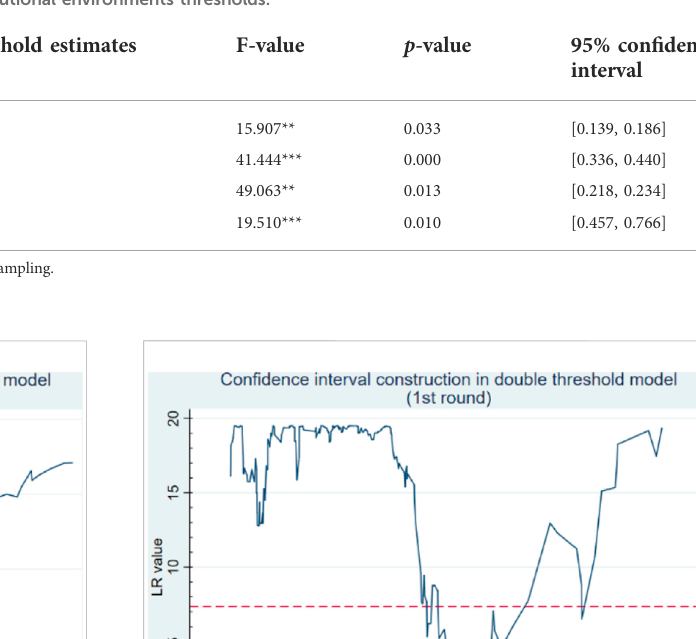
TABLE 6 Signi fi cance test and con fi dence intervals of institutional environments thresholds.